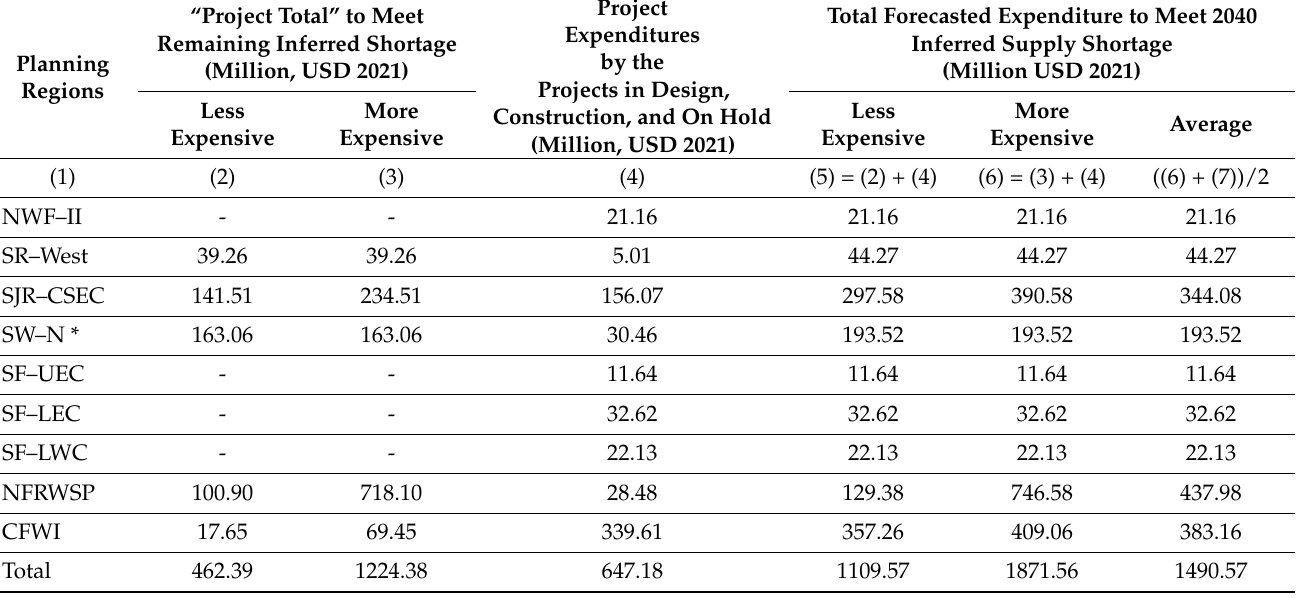
Table 5. Projected Expenditures for the Additional Water Supply using Median Project Expenditures per Unit of